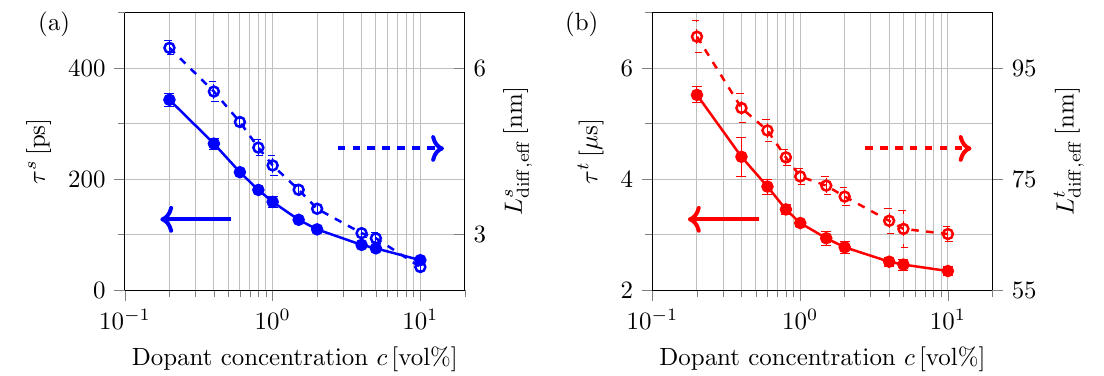
Figure 8. Impact of the dopant volume concentration c on the average exciton lifetime τ (solid curves) and the effective diffusion length L diff,eff (dashed curves) for singlet excitons ( a ) and triplet excitons ( b ).